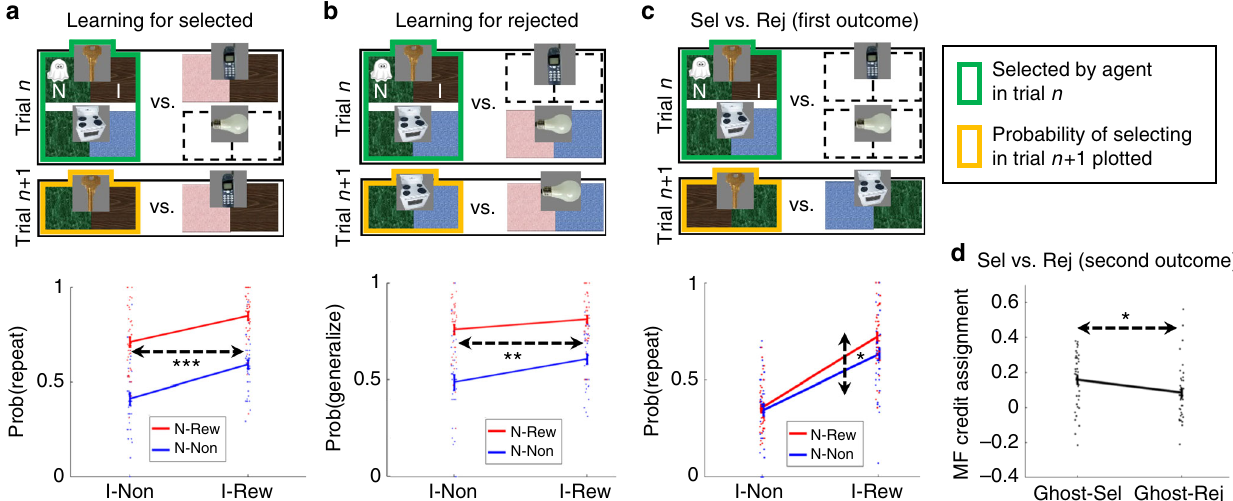
Fig. 4 MF Learning for ghost-nominated and ghost-rejected objects on uncertainty trials. a The probability of repeating a choice, i.e., select the trial- n ghost- nominated object, as a function of the previous-trial non-informative, “ N ” (here green), and informative, inference-allowing, “ I ” (here brown) outcomes (bottom). Only “ repetition ” standard trials that offered for choice the previously ghost-nominated object alongside the object from the previously non- chosen pair, which shared the previously informative outcome with the ghost-nominated object, were analysed. The main effect of the Informative outcome implies that credit from this outcome was assigned by a MF learner to the ghost-nominated object. b Similar to a , but here, the probability to generalize the choice, i.e., select the ghost-rejected object is shown. Only “ switch ” standard trials that offered for choice the previously ghost-rejected object alongside an object from the previously unchosen pair (the one that shares an outcome with the ghost-rejected object) were analysed. The main effect of the Informative (brown) outcome implies that credit from this outcome was assigned by MF to the ghost-rejected object. c Similar to a but only “ clash ” standard trials that offered for choice the previously ghost-nominated and rejected objects, i.e., the previously chosen pair, were analysed. The main effect of the non-Informative outcome (green) implies that credit from this fi rst outcome was assigned by MF mainly to the ghost-nominated object. Each standard trial after an uncertain trial was either a repeat, switch or a clash trial and hence contributed to exactly one of the panels. d Comparing the main effects from the analyses in a and b shows that credit from the second informative, inference-allowing, outcome was assigned by MF mainly to the ghost- nominated object. Error bars correspond to SEM across-participants calculated separately in each condition, n = 40. Dotted arrows indicate the main effect of interest. *,** and *** denote p < 0.05, p < 0.01 and p < 0.001, respectively. In case no asterisks are presented, the effect of interest was not signi fi cant. In a – c p -values were calculated based on a mixed effects logistic regression models. In d , p -values were calculated based on a paired-sample t -test. Dots represent individual participant results. Images adapted from the stimulus set of Kiani et al. 2007, ref.